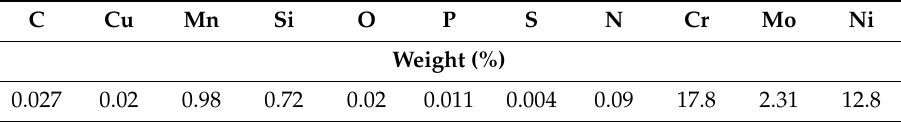
Table 1. 316L steel chemical composition.